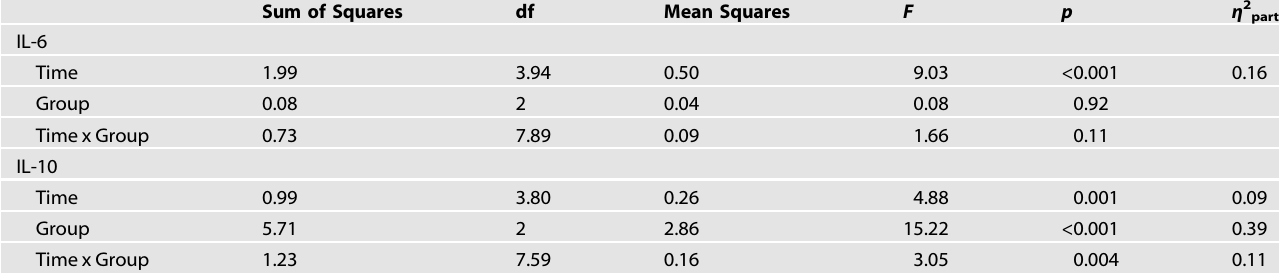
Table 2. Results of repeated measures ANCOVA with cytokine baseline-values ( − 15 min, − 1 min) as covariates. Sum of Squares df Mean Squares F p η 2 part IL-6 1.99